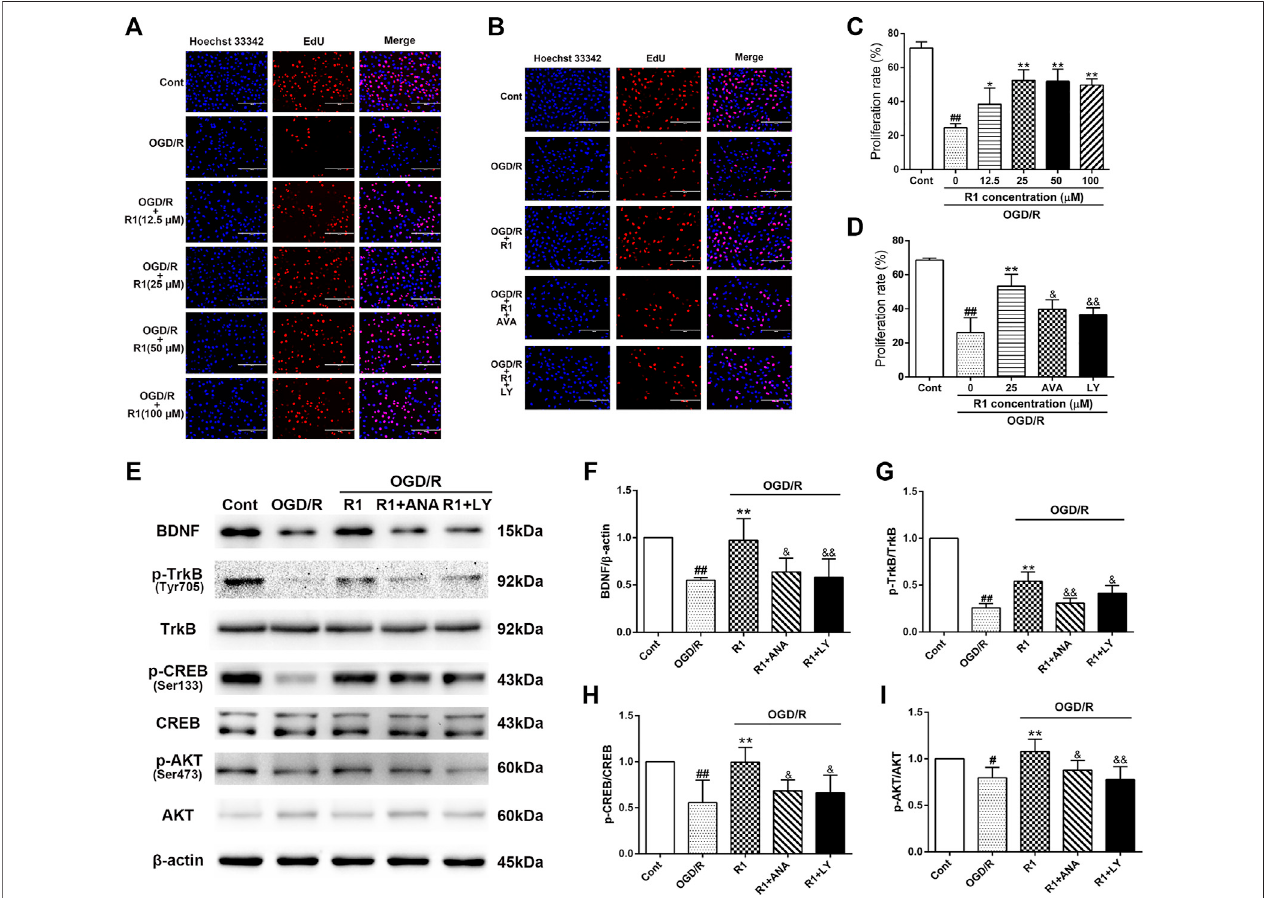
FIGURE 8 | R1 promotes neuronal proliferation though the BDNF and PI3K signaling pathways in vitro (A) R1 promotes neuronal proliferation. PC-12 cells were treatedwithorwithoutR1(drug concentration reachedupto100 µM)for12 h.Imagesofproliferatingneuronsdetected byEdUstaining.NucleiwerevisualizedbyDAPI staining (blue). Scale bar (cid:1) 200 μ m (B) PC-12 cells were pretreated with or without R1 (25 µM) in the presence or absence of ANA-12 (10 μ M) or LY294002 (10 μ M) for 12 h. Imagesof proliferating neurons detected by EdU staining. Nuclei were visualized by DAPI staining (blue). Scale bar (cid:1) 200 μ m (C, D) Proliferation rate ofEdU + cells was analyzed. Representative images of immunoblotting (E) and quanti fi cation of the relative protein levels of BDNF (F) , p -TrkB/TrkB (G) , p -CREB/CREB (H) and p -Akt/Akt (I) in PC-12 cells. n (cid:1) 3 in each group. Data are expressed as the mean ± SD and were analyzed by ANOVA. # p < 0.05, ## p < 0.01 vs. Cont group; * p < 0.05, ** p < 0.01 vs. OGD/R group; and p < 0.05, and p < 0.01 vs. R1